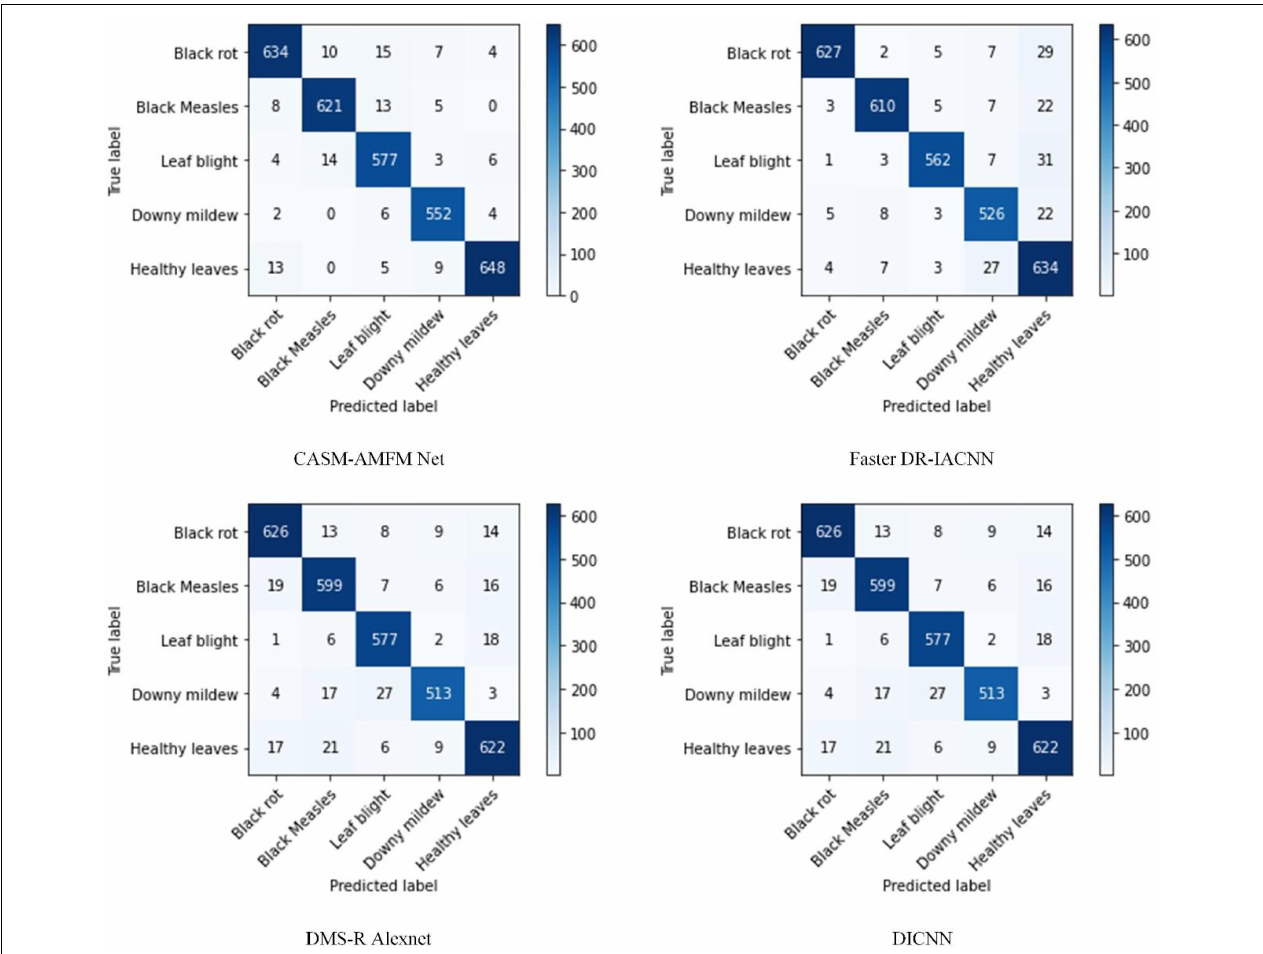
FIGURE 11 | A confusion matrix for the identification of grape leaf